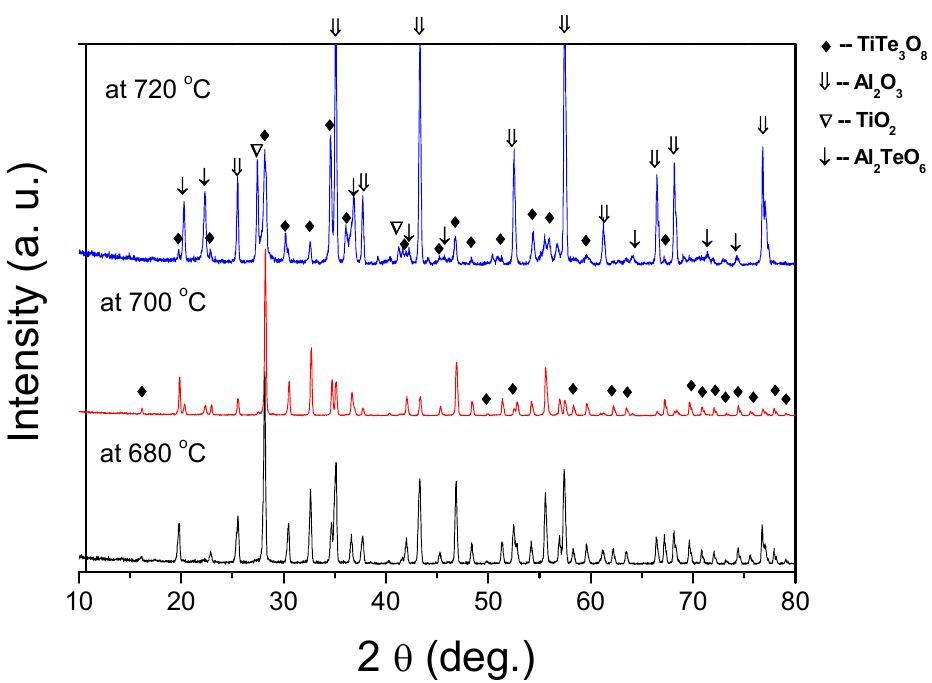
Figure 3. XRD patterns of TiTe 3 O 8 films deposited on carbon coated alumina substrates and sintered at 680, 700 and 720 °C for 5 h. The main film’s phase is TiTe 3 O 8 . For films sintered above 700 °C Al 2 TeO 6 is formed due to a reaction between TeO 2 and Al 2 O 3 substrates.